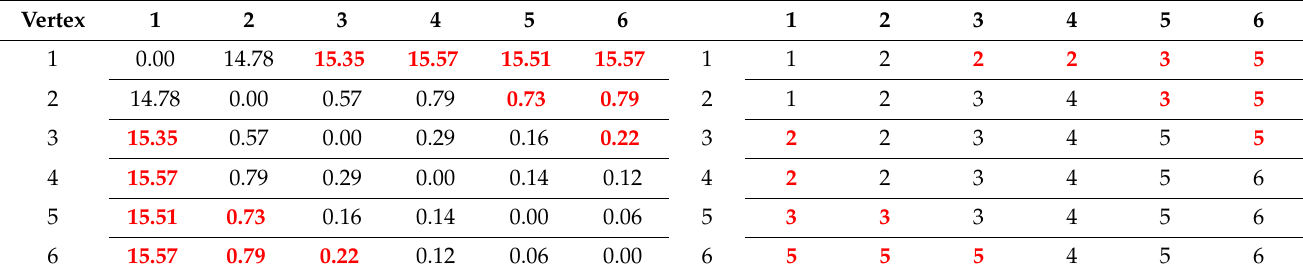
Table 2. Floyd–Warshall algorithm calculation matrix.